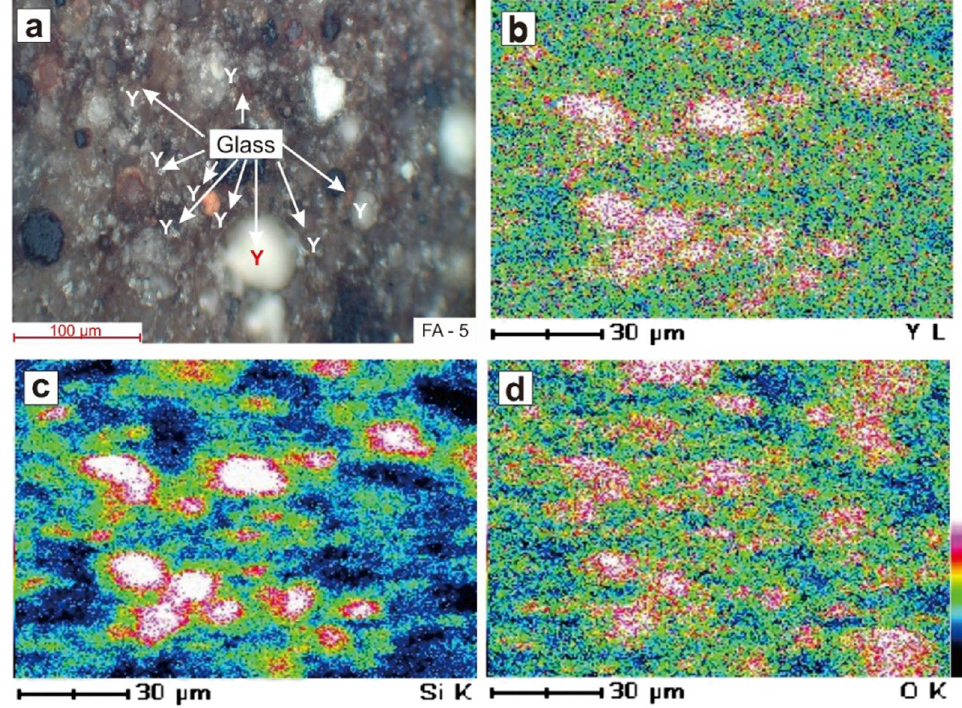
Fig. 14 Mode of occurrence of Y in Glass (sample FA-5). a Optical microscopy of reflected white light; elemental mapping shows the distribu- tion of Y along with the region rich in Si and